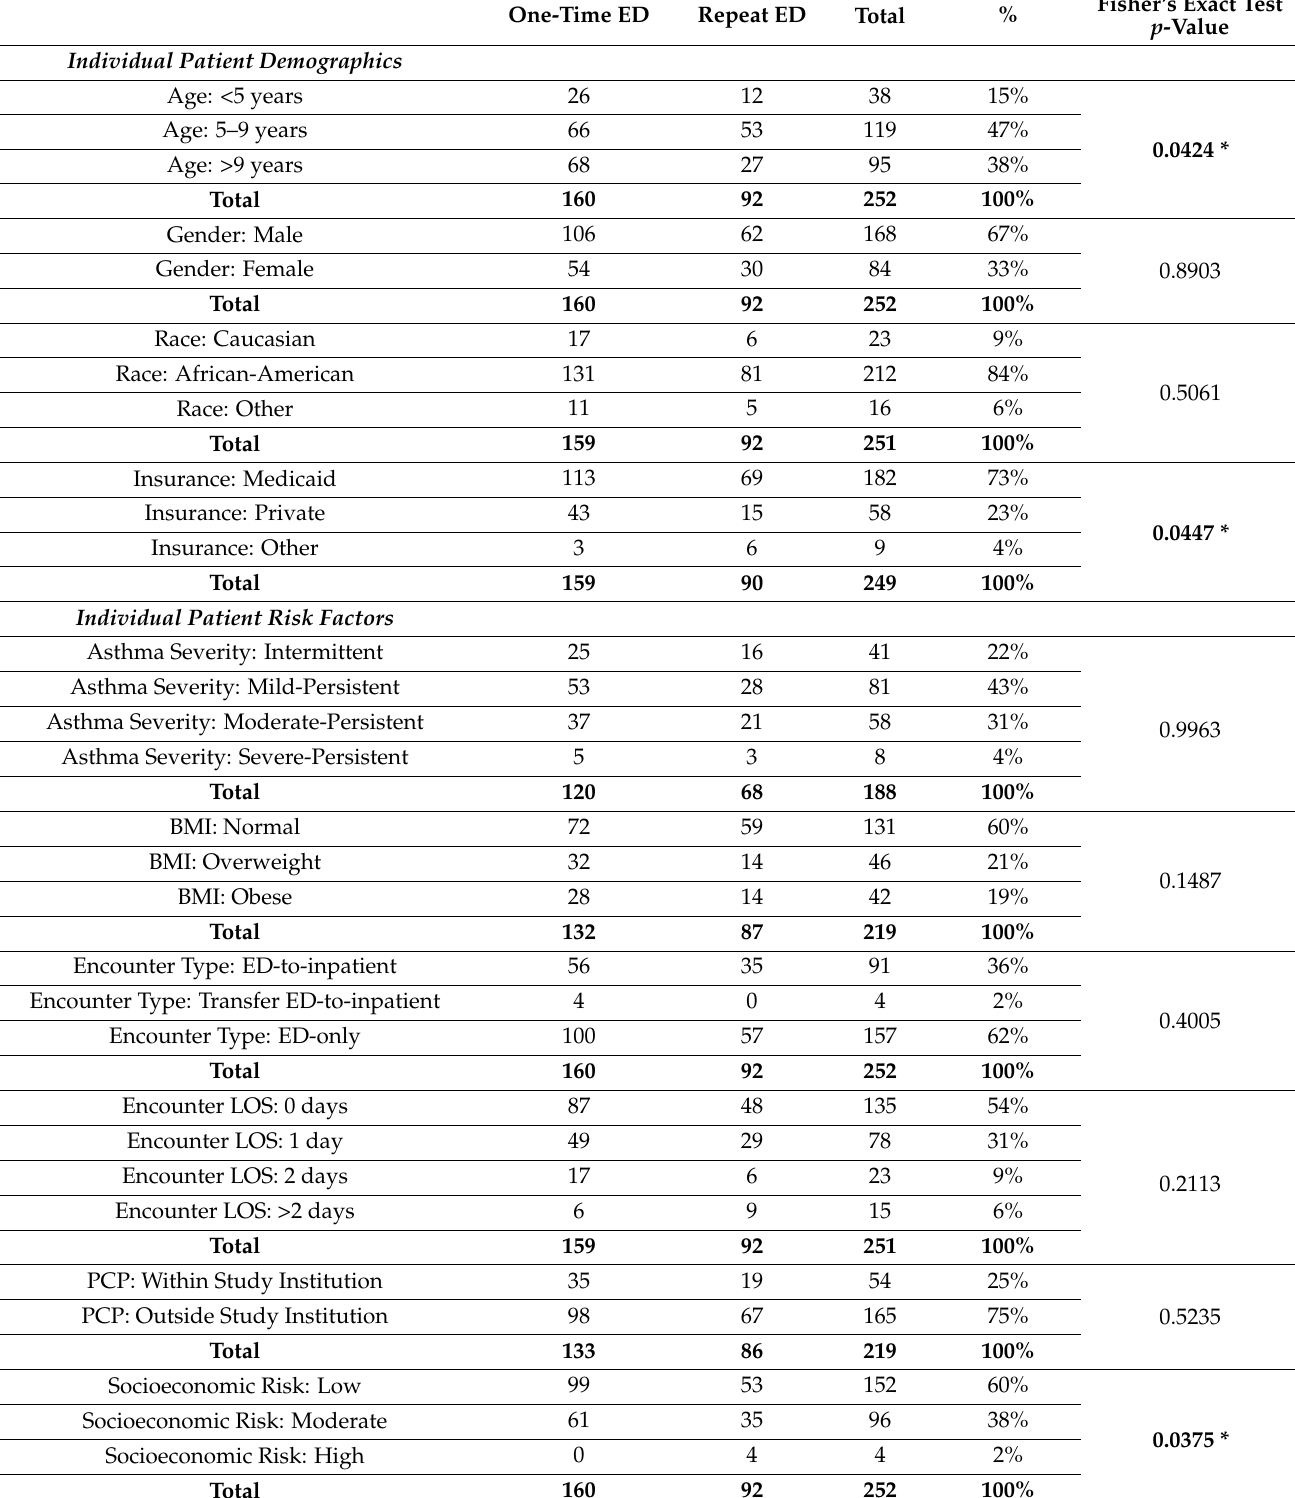
Table 3. Contingency table analysis (Round 1 analysis: 0–17 years). One-Time ED Repeat ED Total %